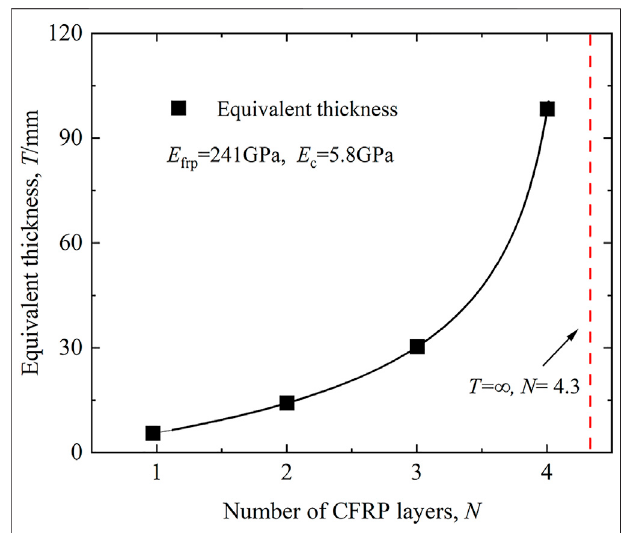
FIGURE 2 | Equivalent thickness of surrounding rock for different numbers of CFRP